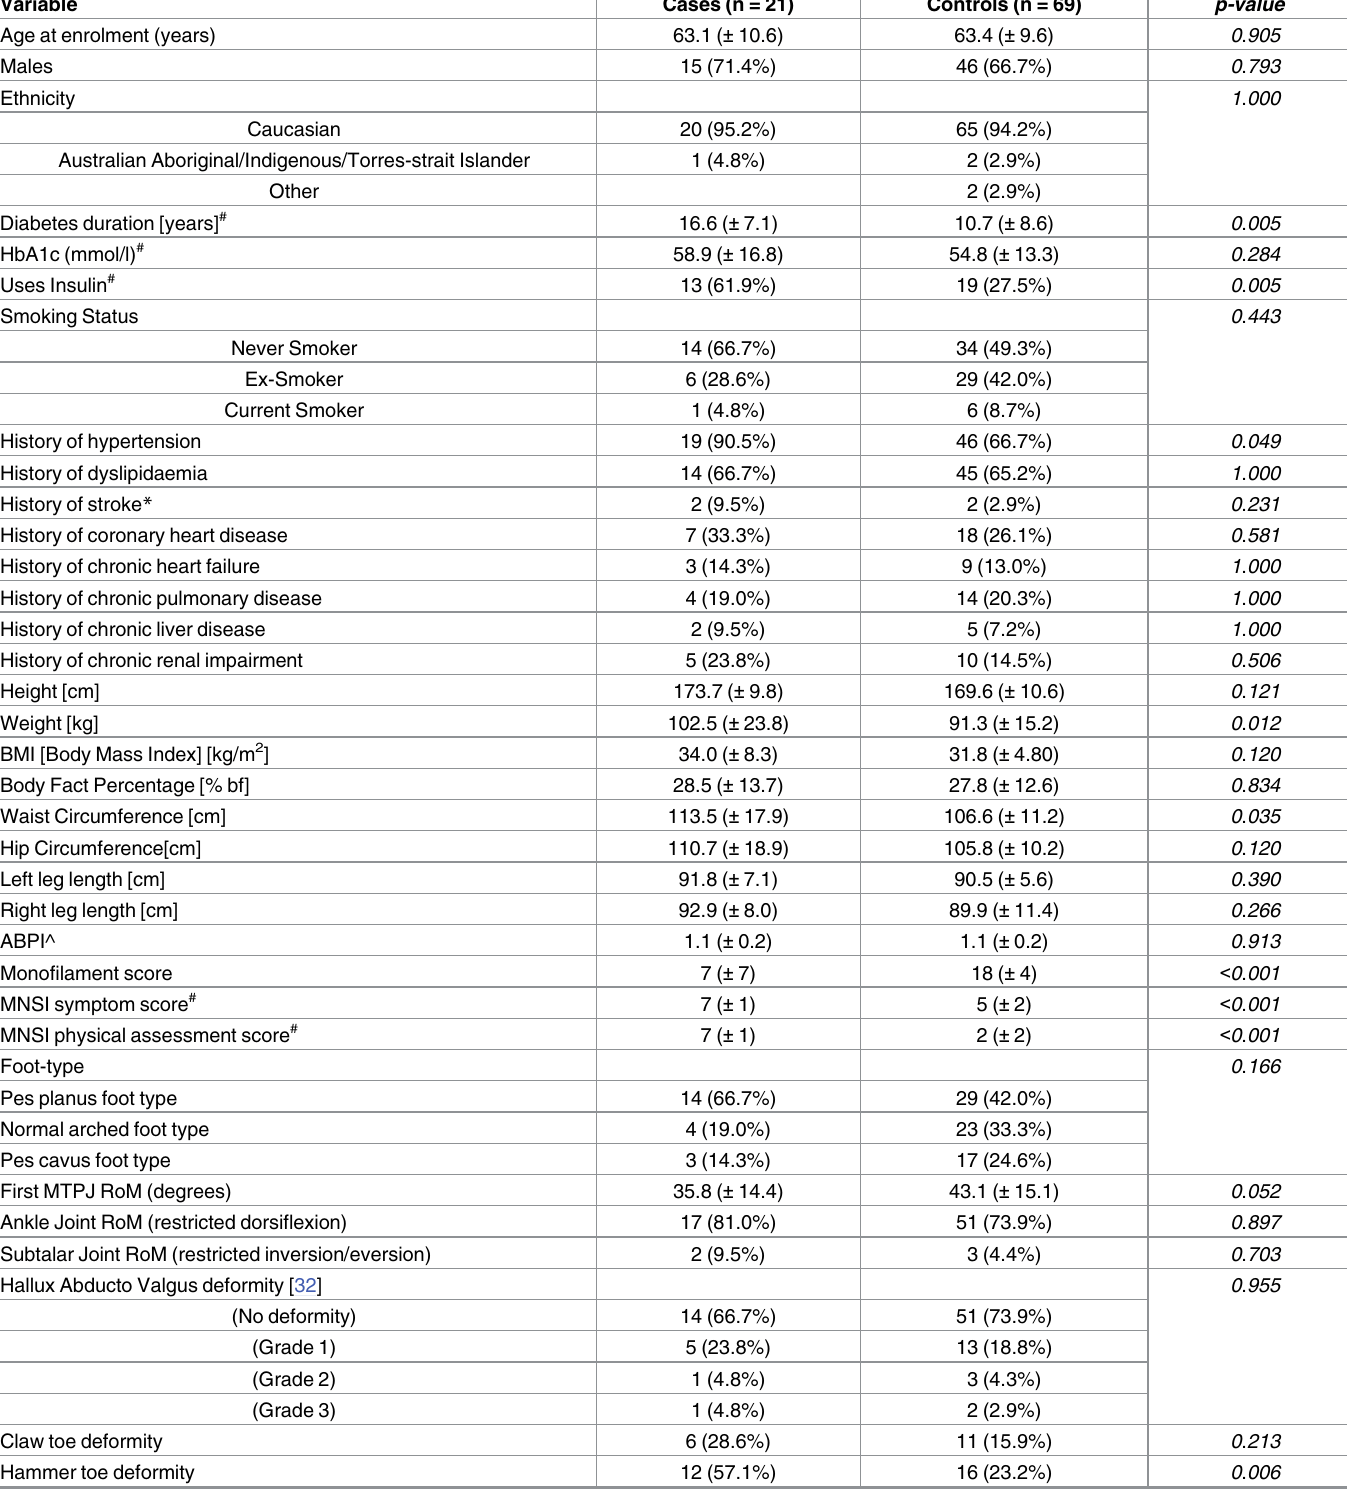
Table 1. Clinical and demographical characteristics of the enrolled study cohort at